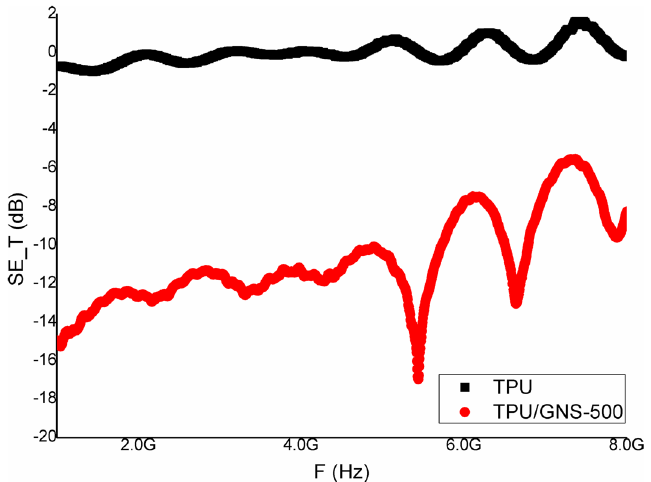
Figure 7. Experimental EMI shielding effectiveness results for TPU and TPU/GNS-500 Composite based on s-parameters as function of frequency (1–8